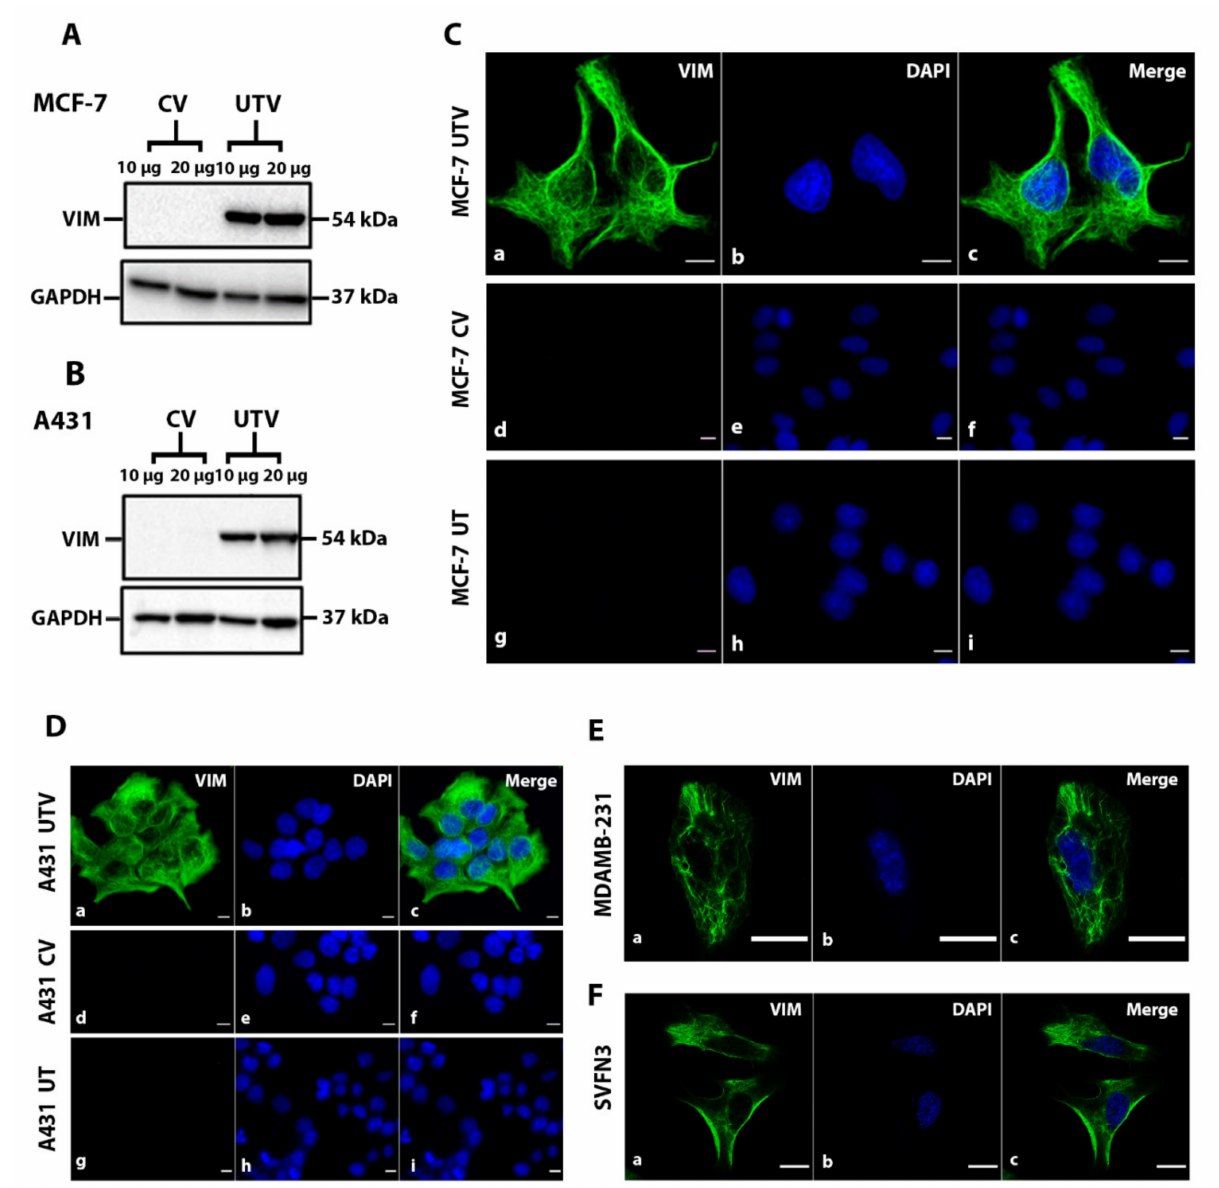
Figure 2. Ectopic expression of vimentin in vimentin-deficient cells. ( A ) MCF-7 and ( B ) A431 cells were transduced with the untagged vimentin (UTV) and its control vector (CV) by recombinant retrovirus supernatant. Total protein extract, 10 and 20 µ g, from each transduced cell line were loaded onto SDS PAGE gels, transferred onto nitrocellulose and probed with anti-vimentin antibody to confirm the transduction efficiency. GAPDH was used as the loading control. Relevant bands were cropped from different gels and regrouped. Original blots are shown in the Supplementary Figure S2. Immunostaining of ( C ) MCF-7 and ( D ) A431 cells transduced with CV and UTV constructs. Untransduced (UT) MCF-7 and A431 cells were also used as controls. Cells were immunostained with anti-vimentin antibody and counter stained with AF-488-labelled goat anti-mouse secondary antibody showing green fluorescence. Nuclei were stained with DAPI in blue and overlapping images are shown as ‘Merge’. Leica DM4000B Epi-fluorescence microscope and DFC350 camera were used for recording images. Immunostaining of ( E ) MDA-MB-231 and ( F ) SVFN3 cells expressing endogenous vimentin were also immunostained with anti-vimentin antibody. The vimentin staining in SVFN3 and MDA-MB-231 cells was very similar to that in transduced MCF-7 and A431cells shown in C and D (scale bar = 20 µ